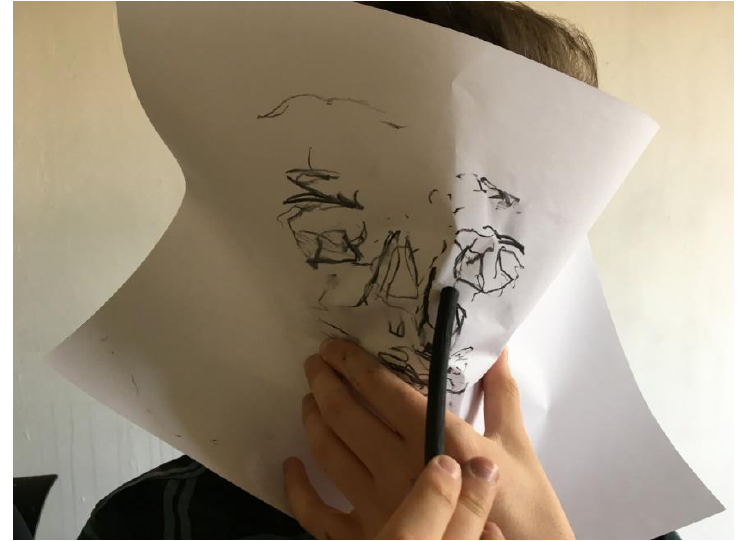
Figure 4. Thomas, J (2018). Year 1 student self-portrait.